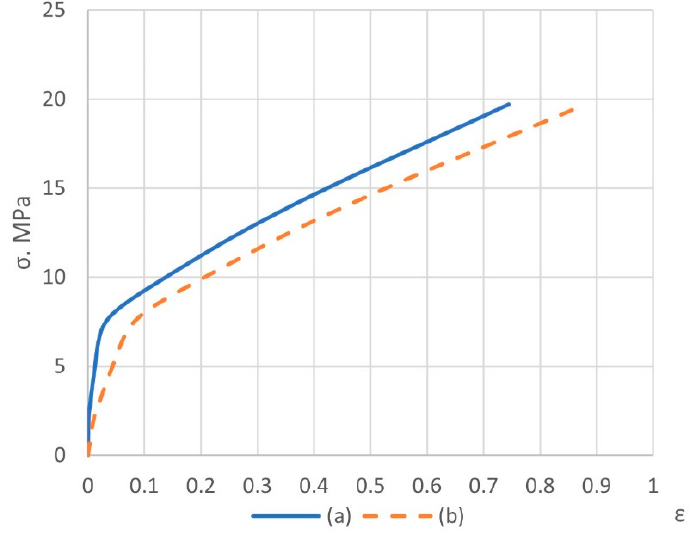
Figure 11. Equivalent stresses according to von Mises stress, Pa for matrix ( a ) and filler ( b ) and equivalent plastic strain ( c ) with short cylindrical filler at the moment of loss of bearing capacity (first stage).